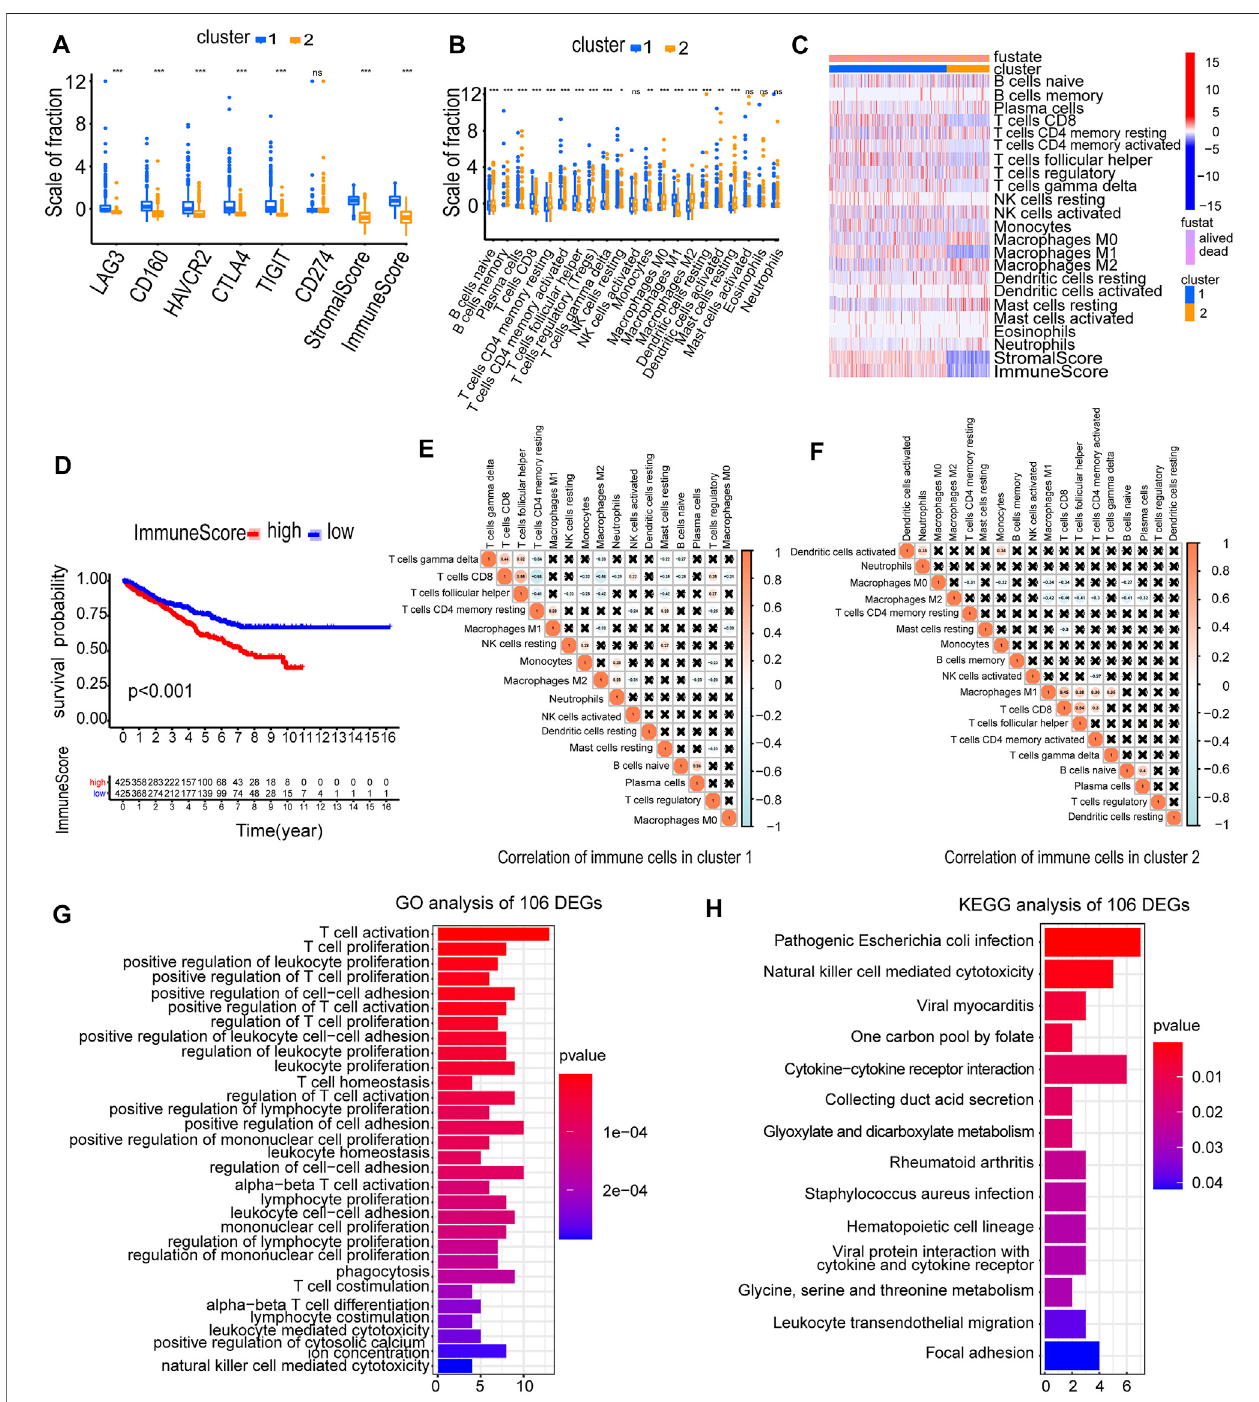
FIGURE4| Immune status analysis of two clusters and functional enrichment analysis of 106 DEGs. (A) Expression of immune checkpoints in two clusters of RCC. (B) TheabundanceofimmunecellsintwoclustersofRCC. (C) Theheatmap oftheabundanceofimmunecellsintwoclusters. (D) Thesurvivalcurvesofhigh and low immune score groups showed signi fi cant prognostic differences. (E) Correlation matrix of in fi ltrating immune cells in cluster 1. (F) Correlation matrix of in fi ltrating immune cells in cluster 2. The numbers in the two matrices represent the Pearson correlation coef fi cient. The coral circle represents a positive correlation, the blue circle represents a negative correlation, and the white circle represents no correlation between two kinds of cells. (G) GO term enrichment in the biological process of 106 DEGs. (H) KEGG enrichment analysis of 106 DEGs. * p < 0.05; ** p < 0.01; and *** p < 0.001.